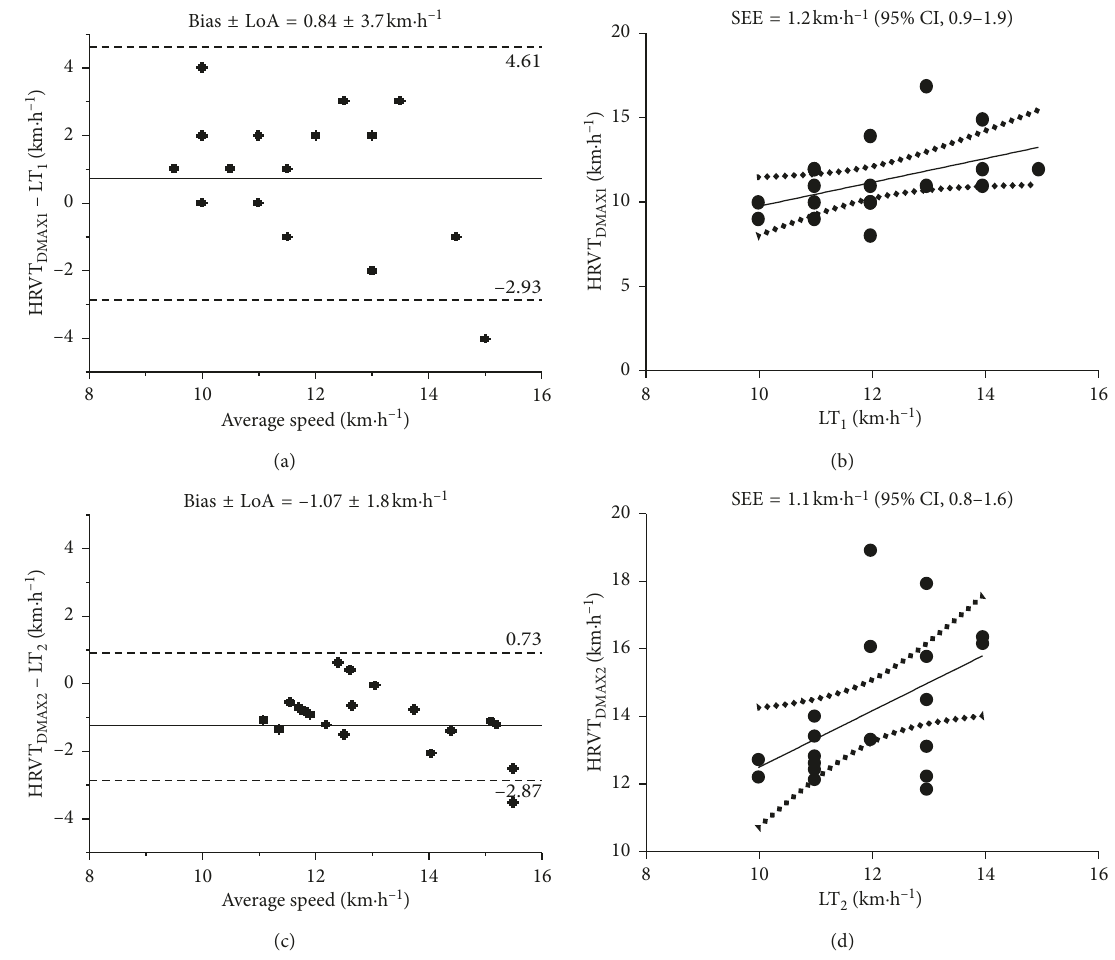
Figure 2: Bland and Altman plot for the agreement between HRVT DMAX1 and LT 1 (a), and HRVT DMAX2 and LT 2 (c), with bias (continuous line) and the 95% limits of agreement (discontinuous lines) for speed measures. The relationship between HRVT DMAX1 for speed and LT 1 (b) and HRVT DMAX2 and LT 2 (d) measures; solid and dashed lines represent the regression line and the 95% confidence intervals, respectively. Table 3: Reliability analysis for HRVT DMAX1 , HRVT DMAX2 , LT 1 , and LT 2 .